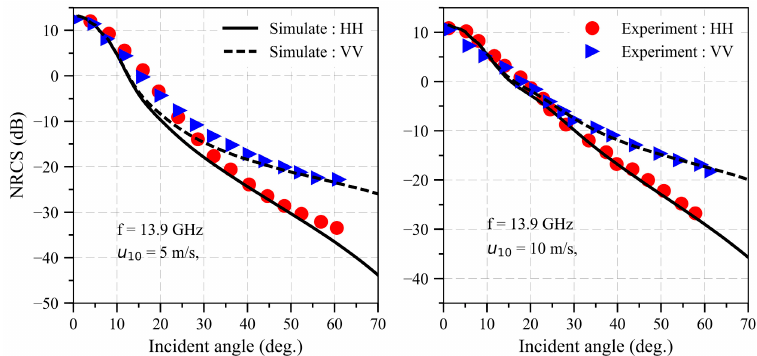
Figure 4. NRCS of electrically large oceanic surface compared with the experiment data when the frequency is equal to 13.9 GHz at different wind speed.